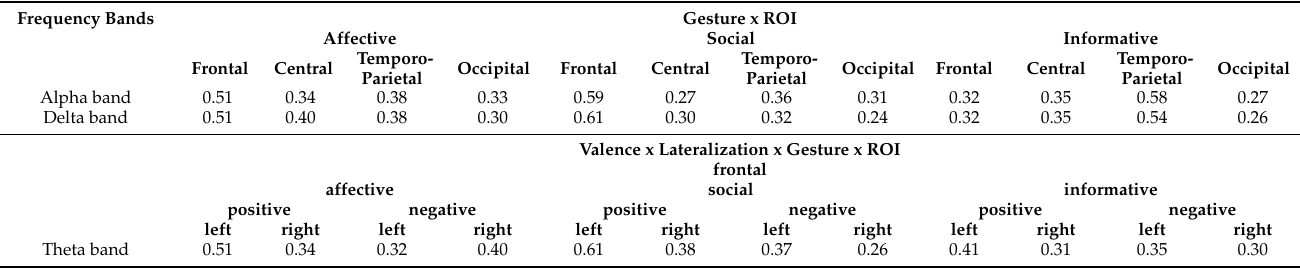
social (middle), and informative (right side) gestures. The increase in delta intra-brain connectivity is marked by the red area. ( E ) A bar chart of theta intra-brain connectivity for affective, social, and informative positive and negative gestures in the left and right cerebral side. The bar chart shows the increase in left frontal theta intra-brain connectivity for positive gestures. Bars indicate ± 1 SE. Statistically significant pairwise comparisons ( p < 0.05) are marked by an asterisk. ( F ) Theta intra-brain connectivity representations for affective (left side), social (middle), and informative (right side) gestures. The increase in theta intra-brain connectivity is marked by the red area. Table 1. Table of intra-brain connectivity results (means of intra-brain